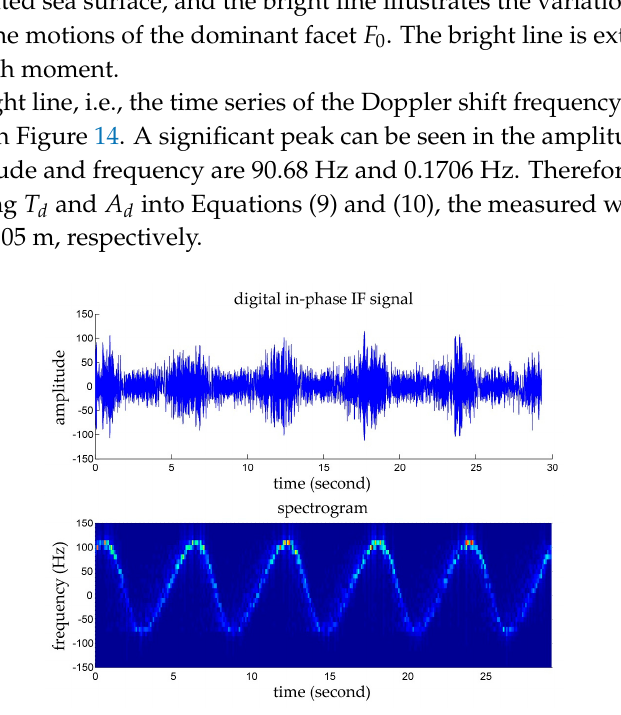
Figure 13. IF signal and its spectrogram. The upper figure is the in-phase signal and the fluctuation of its amplitude reflects the wave propagation. The quadrature signal is not shown here. The in-phase signal and quadrature signal are the real part and the imaginary part of the complex IF signal, respectively. The strong signal in the lower figure originates from the dominant facet F 0